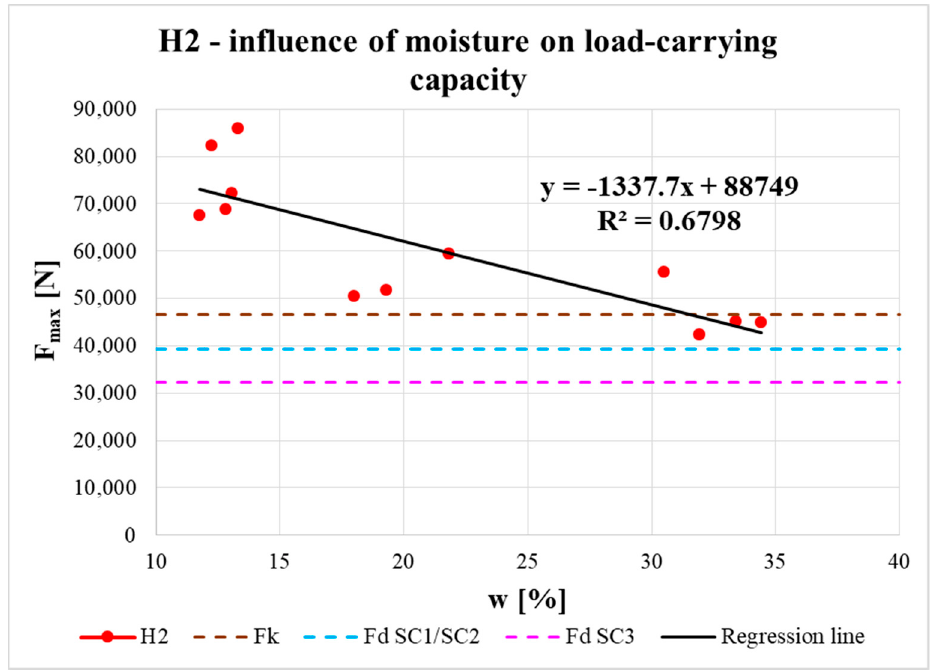
Figure 18. Influence of moisture content on load-carrying capacity of H2 specimens.